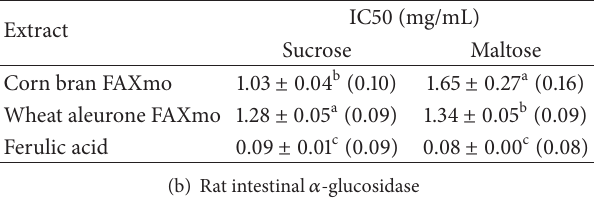
Table 1: Effect of ferulic acid and feruloylated arabinoxylan mono- and oligosaccharide extracts on 𝛼 -glucosidase when sucrose or maltose was used as substrate.